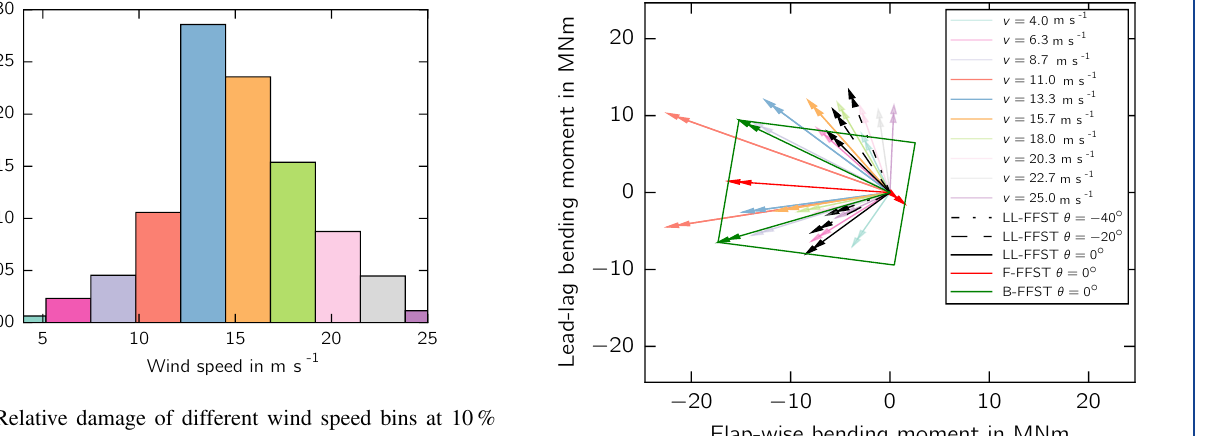
Figure 3. Relative damage of different wind speed bins at 10% blade length.